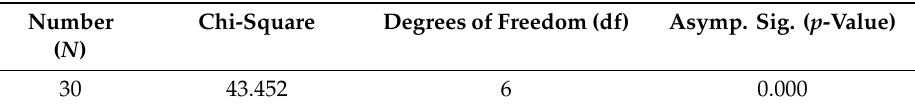
Table 5. Statistics of the Friedman test.